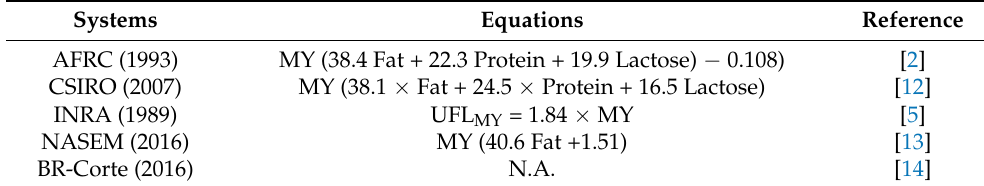
Table A6. Equations to calculate energy contents in milk